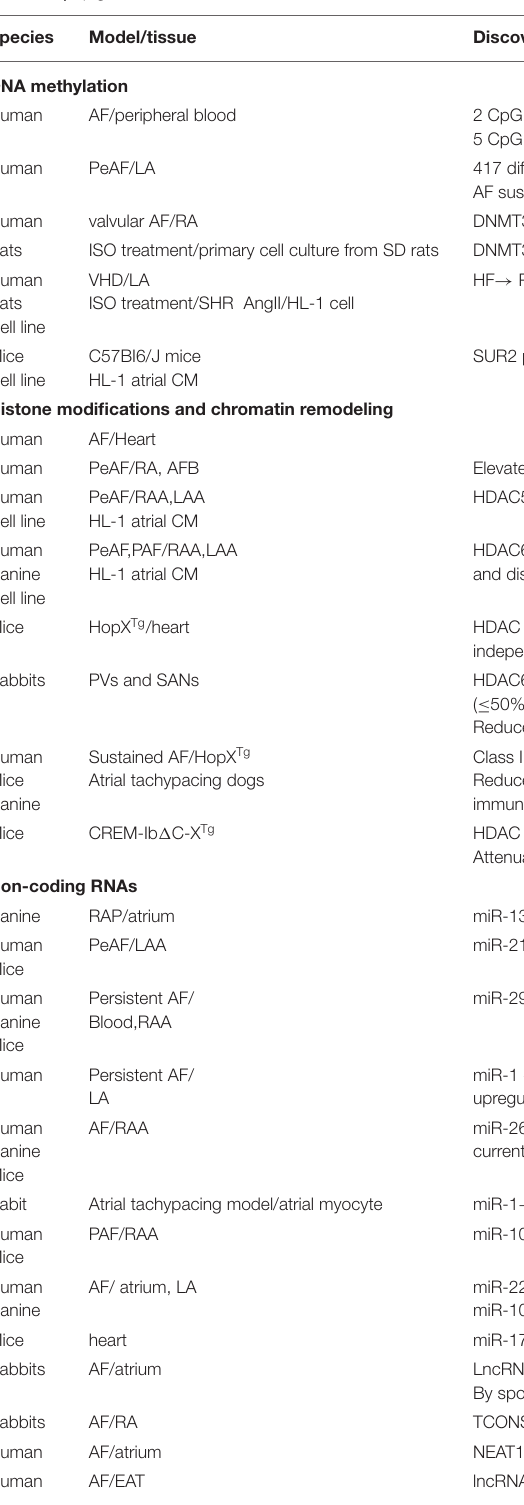
TABLE 1 | Epigenetic modification in AF.